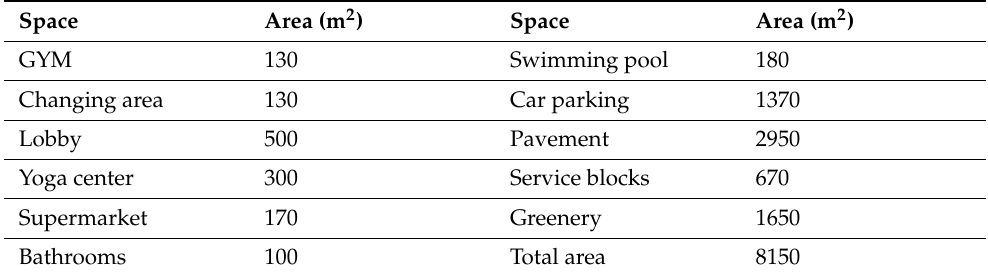
Table 1. Existing building program.